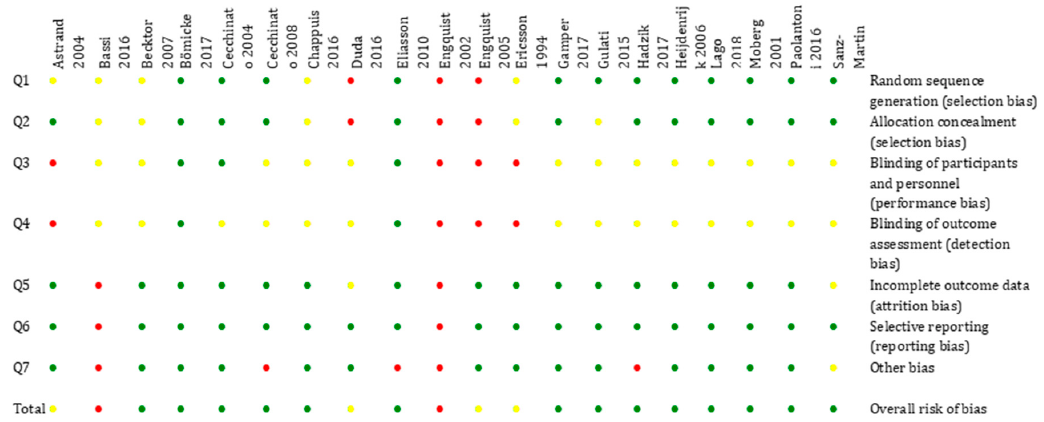
Figure 3. Risk bias word: red–high risk; yellow–unclear; risk green-low risk.